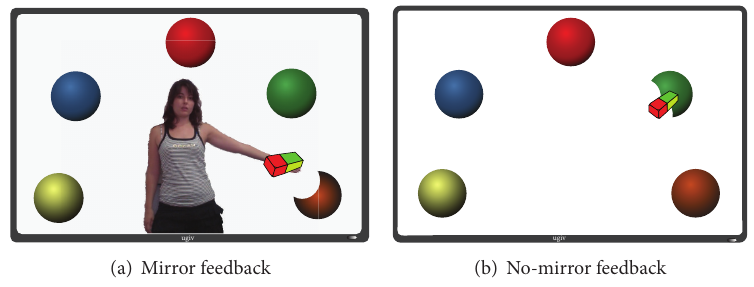
Figure 4: Experimental feedback conditions.